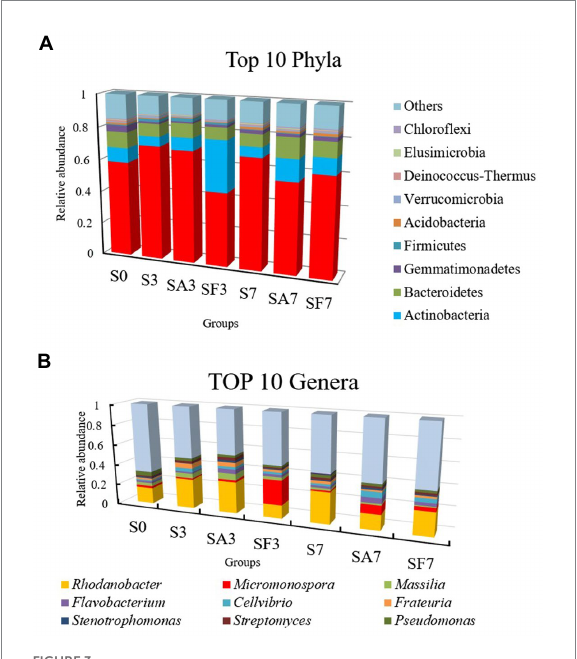
FIGURE 3 Assembly of core rhizosphere microbial communities. (A) Community bar-plot analysis of the relative abundance of rhizosphere microbial communities in the different soil groups at the phylum level. (B) Community bar-plot analysis of the relative abundance of rhizosphere microbial communities in the different soil groups at the genus level. S0, Mock-inoculation control (before treatment); S3, mock-inoculation control, 3 dpi; S7, mock-inoculation control, 7 dpi; SA3, SA + FON treatment, 3 dpi; SA7, SA + FON treatment, 7 dpi; SF3, FON treatment, 3 dpi; SF7, FON treatment, 7 dpi. FON, Fusarium oxysporum f. sp. niveum ; SA, salicylic acid; dpi, days post inoculation. Three biological replicates per sample were analyzed. Data are expressed as mean ± SE ( n =